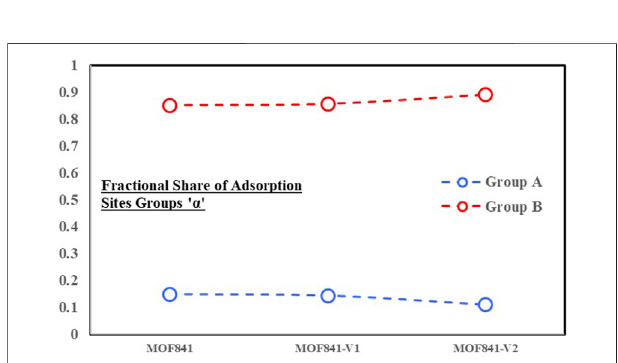
FIGURE 8 | Variations in the surface heterogeneity of MOF 801 and variants.